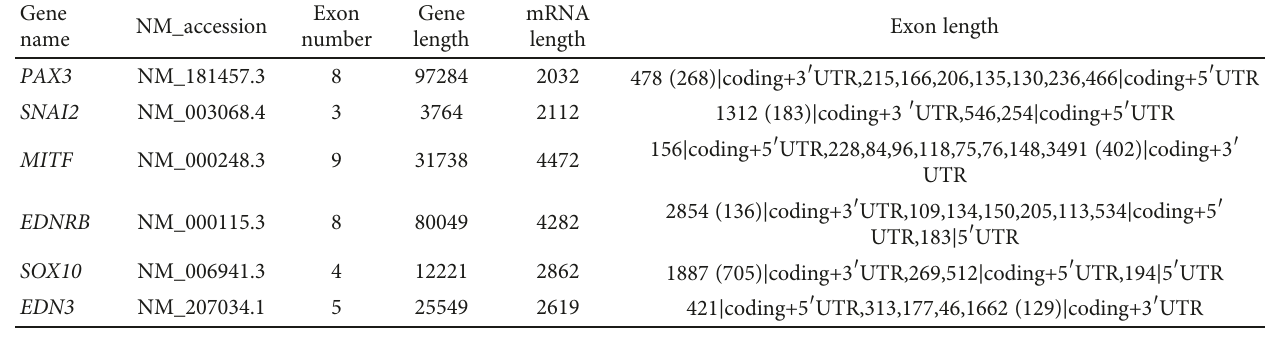
Table 2: WS-associated genes and their PCR target regions.